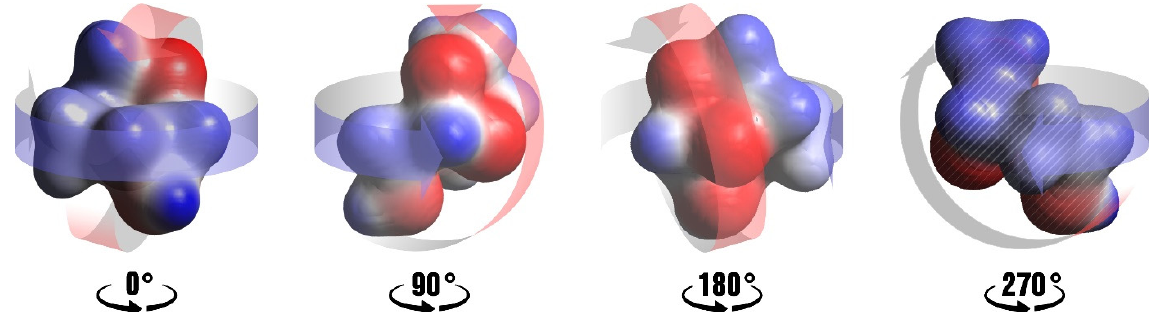
Figure 2. An electrostatic potential mapped on the surface of I ; electro-positive regions in blue, electro-negative regions in red.